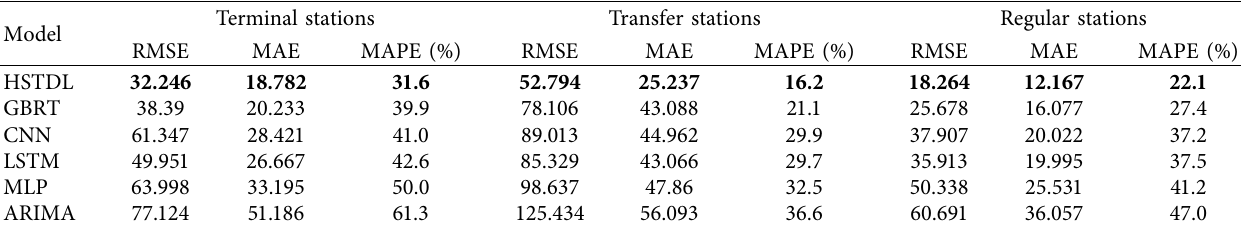
Figure 8: Visualization of model comparison results. Table 5: The comparison of different models (inbound passenger flow).